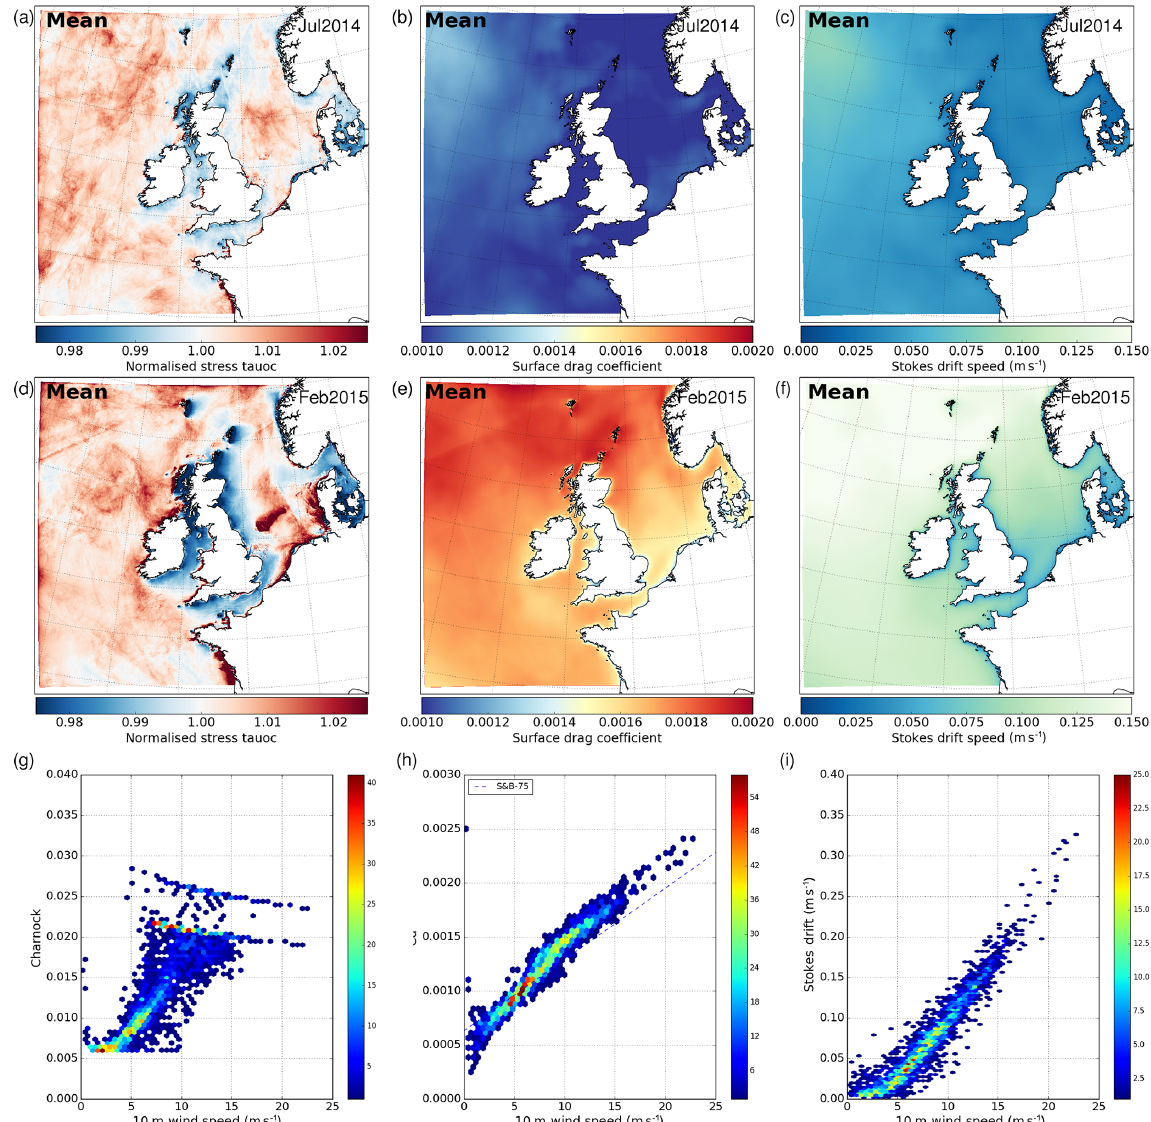
Figure 2. Wave model climatology from UKW3g of coupling-related variables – (a, d) normalized stress fraction tauoc, (b, e, h) wave- modified surface drag coefficient and (c, f, i) Stokes drift speed. The maps in (a) – (c) show monthly mean values from the July 2014 “sum- mer” period and in (d–f) from the February 2015 “winter” period. Binned scatter plots on the bottom row show the simulated variation of (g) Charnock parameter, (h) drag coefficient and (i) Stokes drift speed as a function of wind speed across all simulated months in April, July, October 2014 and February 2015 at a point in the central North Sea. Similar distributions are found across the model domain. Colours show the frequency of data within each bin. In (h) , the nn_drag = 0 NEMO formulation is plotted by the S&B-75 dashed blue